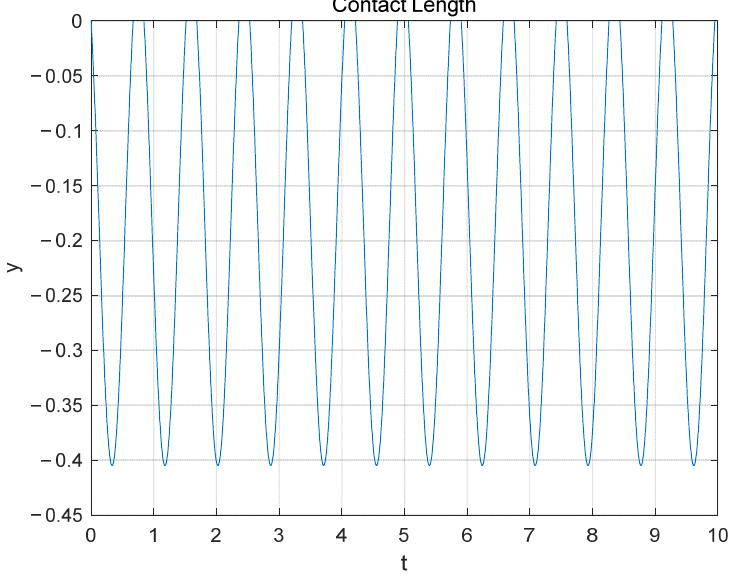
Figure 16. Longitudinal displacement of the robot in the ground contact state.